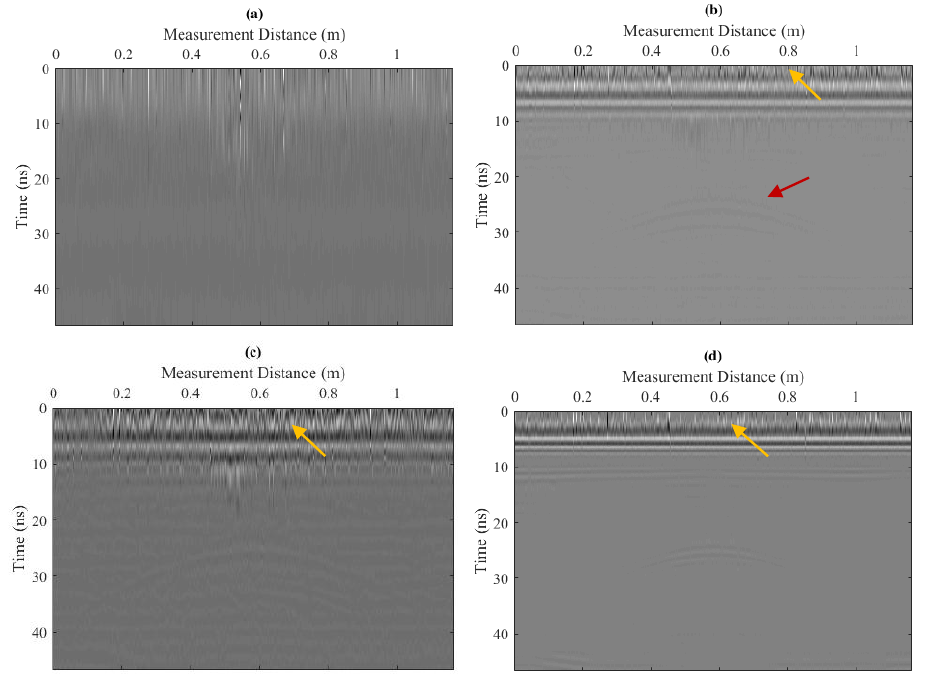
Figure 10. The derived IMF-slices using EMD. ( a – d ) show the IMF-slice 1–4 respectively.